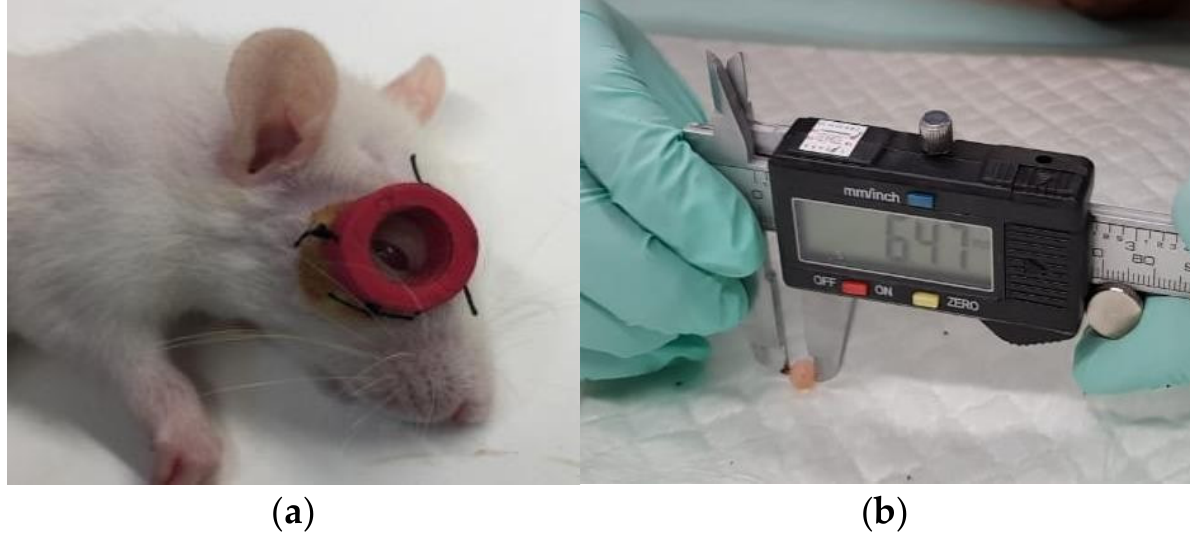
Figure 1. The procedure performed in this study. ( a ) Induction of myopia was conducted using the LIM method (attachment of S -10.00 D lens to the rat’s right eye); ( b ) axial length measurement used electronic digital calipers.